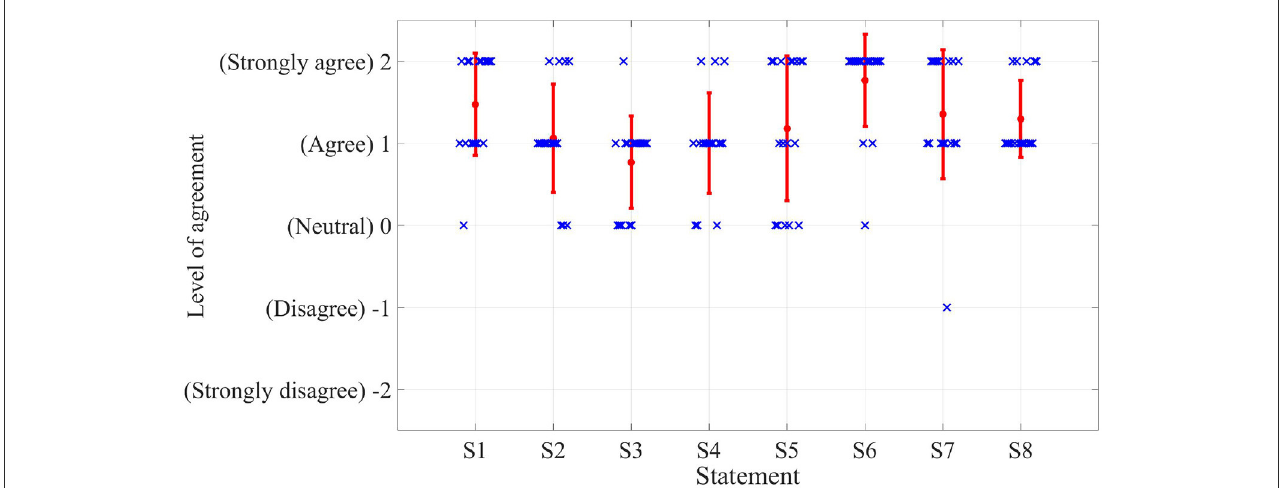
FIGURE11 Detailed results of the user study for the subjective evaluation of PREDICTOR. The eight statements are listed on the x-axis while the level of agreement in terms of score is shown on the y-axis. The red dots and bars represent the means and standard deviations while blue crosses indicate the specific scores for different statements from all the subjects.